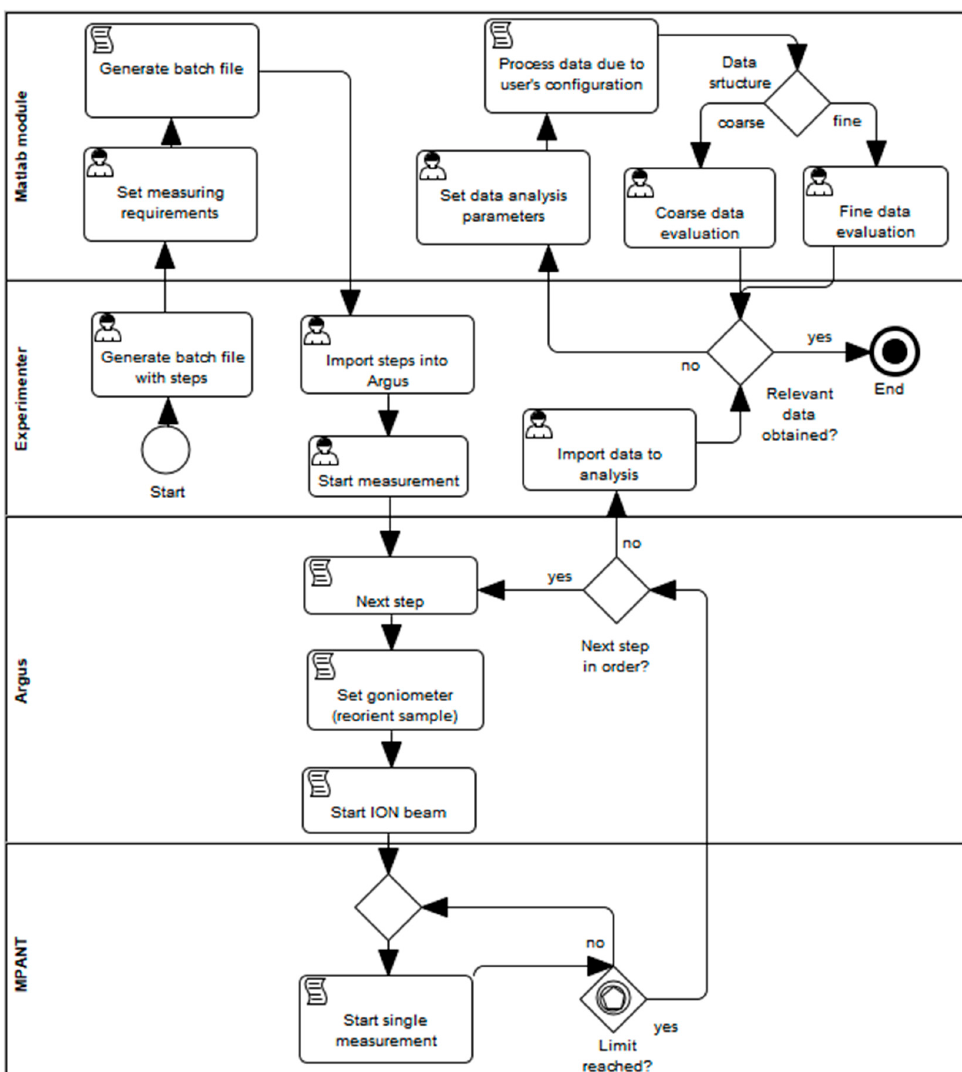
Figure 9. Designed measurement algorithm and data flows.